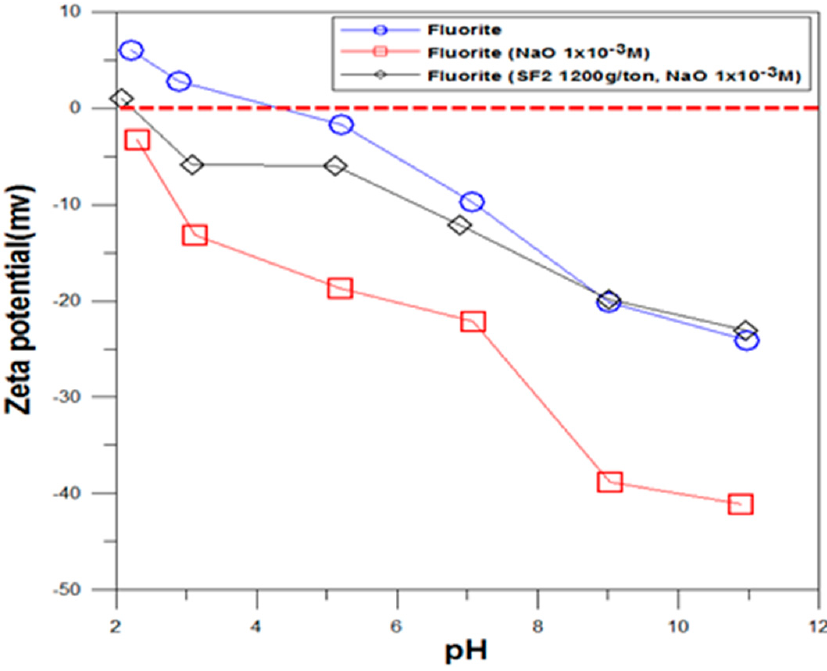
Figure 8. Zeta potentials of fluorite with and without the collector and depressant.